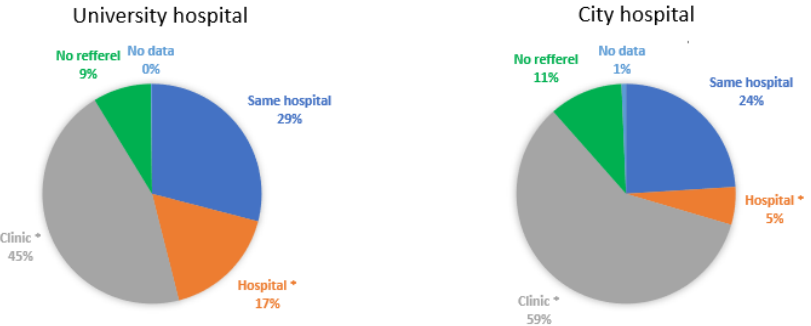
Figure 3. Referral source. Patients were referred from the same hospital (blue), other hospitals (orange), or other clinics (grey). Patients could directly come to the outpatient units without medical referral letters (green). Data regarding the referral sources were missing in some patients (light blue). * p < 0.05 between the university hospital and the city hospital with Bonferroni correction.